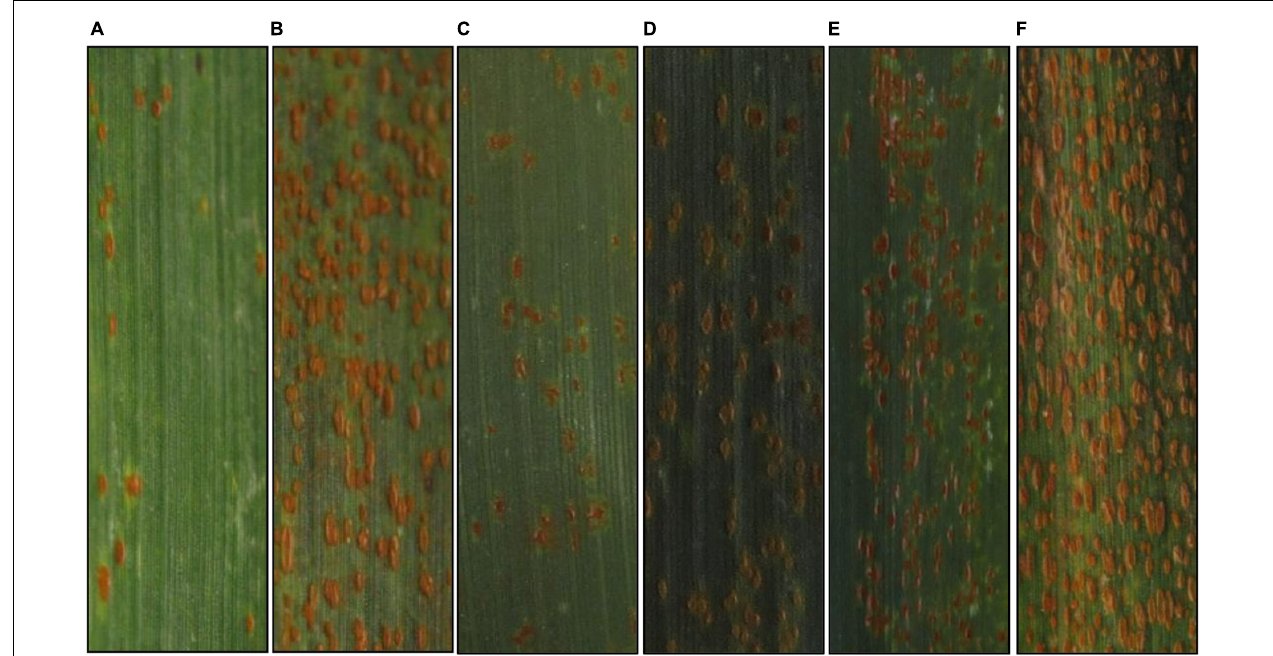
FIGURE 1 | Typical symptoms of the parental and control wheat lines infected by Puccinia triticina race THTT under greenhouse conditions. (A–F) Denote Bai Qimai (BQM), Nugaines (NG), RL6058, Aikang58 (AK58), Jimai22 (JM22), and Mingxian169 (MX) at the adult plant stage, respectively.